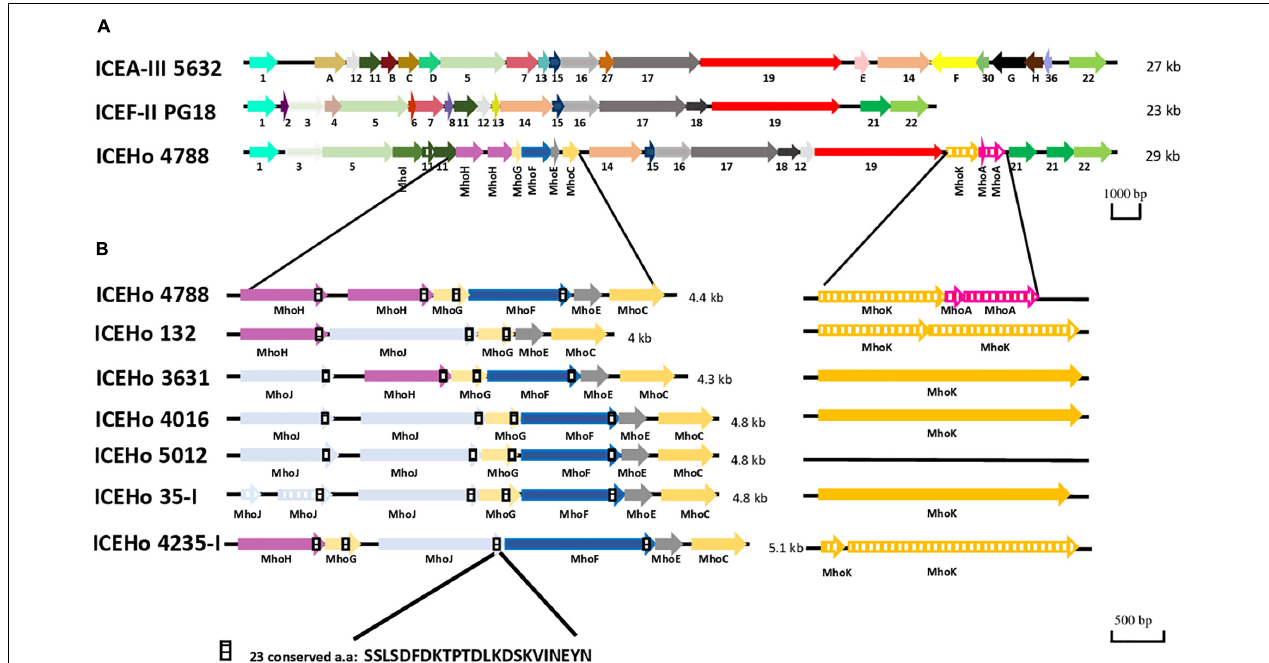
FIGURE 1 | Genetic organization of integrative and conjugative elements (ICEs) from M. hominis , M. agalactiae , and M. fermentans . (A) Comparison of ICEs present in M. hominis 4788 (ICEHo 4788), M. agalactiae 5632 (ICEA-III), and M. fermentans PG18 (ICEF-II). (B) Genetic organization of the specific M. hominis ICE module in the ICEHos of the seven sequenced M. hominis strains harboring complete ICEHos. ICEs are designated according to their originally proposed names. M. hominis ICEs are designated with same number as the M. hominis strain from which they are originated from (e.g., ICEHo 4788 is from M . hominis 4788 strain). Arrows represent coding sequences (CDSs), hatched arrows represent pseudogenes. Homologous CDSs are identified by the same color and same number or letter underneath, using previously described nomenclature. ICEHo 4788 CDSs that had no homology with CDSs reported previously in mycoplasma ICEs (MICEs) were designated as Mho plus a letter (MhoA to